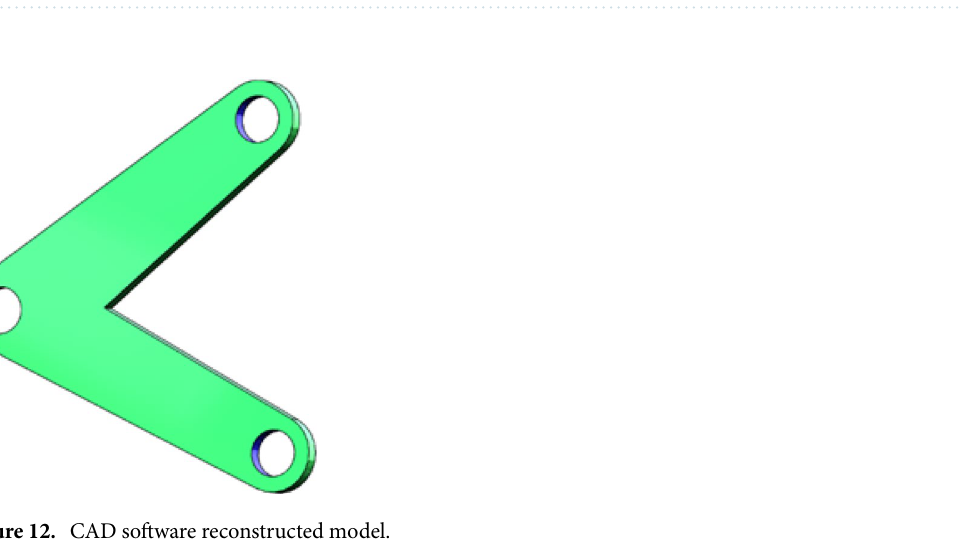
Figure 11. Comparison of optimization results with different optimization algorithms. ( a ) HCAM optimization result ( b ) FEM optimization result.